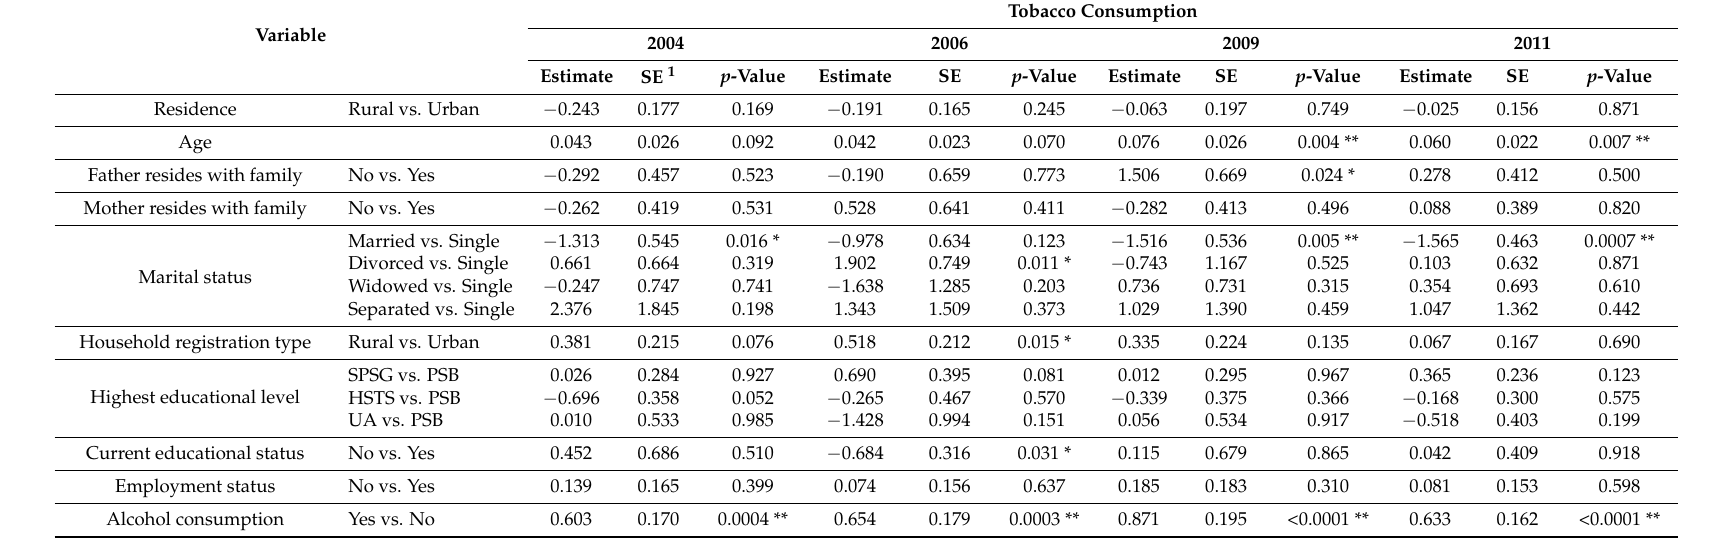
Table 3. Penalized logistic regression analysis of tobacco consumption among adult women of reproductive age (continuous variable).